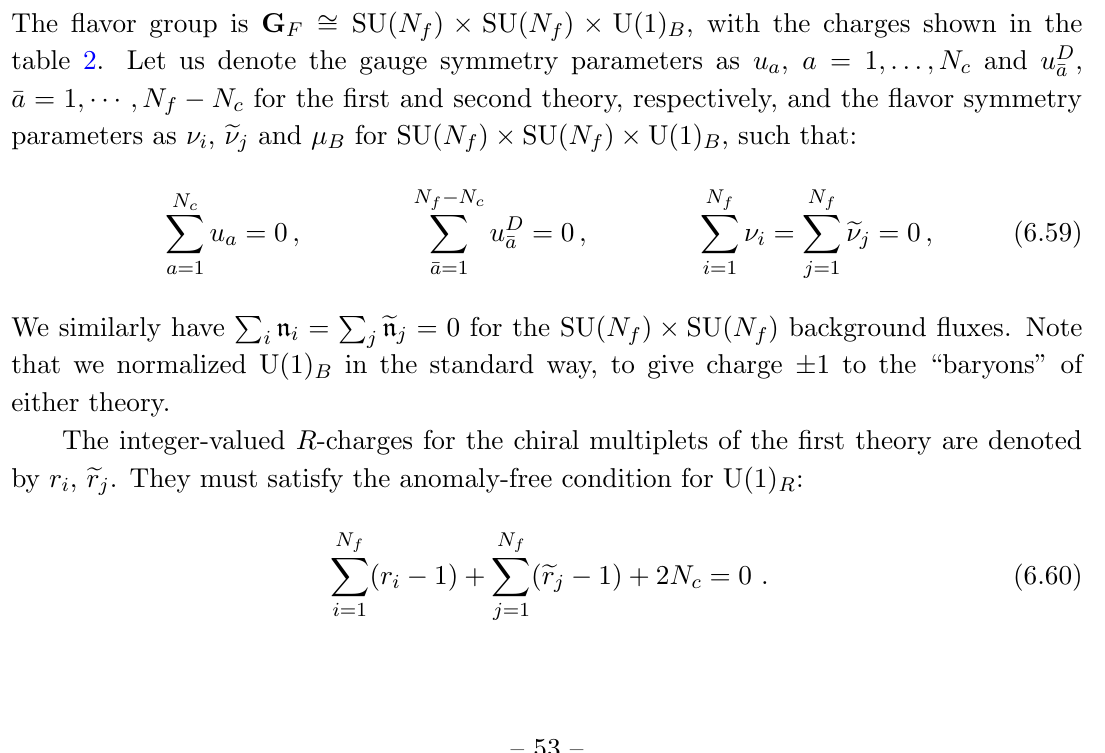
table 2. Let us denote the gauge symmetry parameters as u